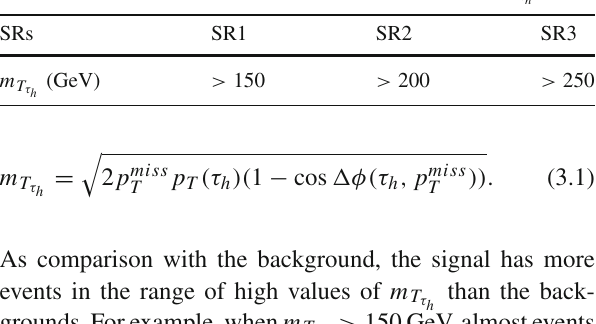
Fig. 15 The normalized distributions of p T ( j 1 ) , p T (τ h ) , E miss = 369 GeV, m ˜ τ = 377 GeV is m ˜ χ 0 1 1